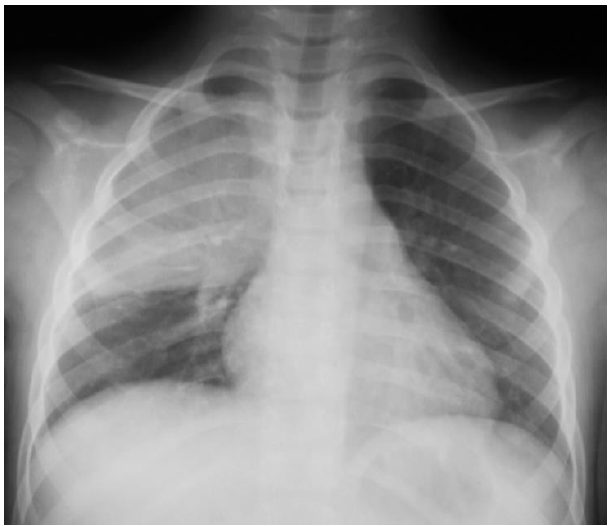
Figure 7. Opacity of medial right lobe, correspondent CXR.